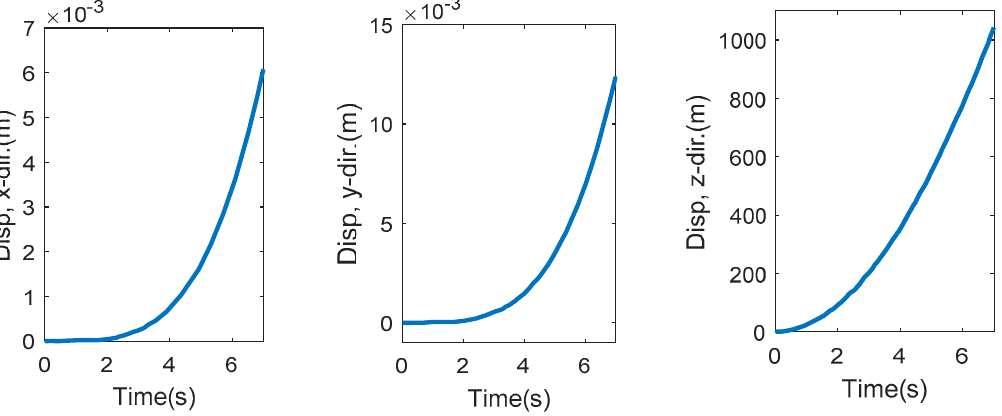
Figure 11. Variation of displacements in the robustness scenario.